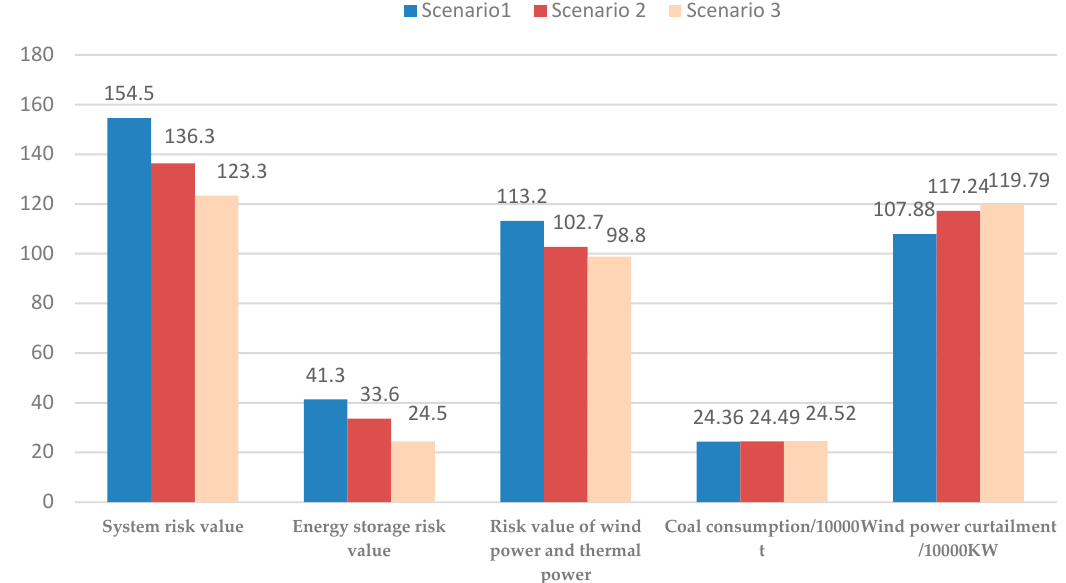
Figure 6. Variety of the indexes of scheduling results in three scenarios.